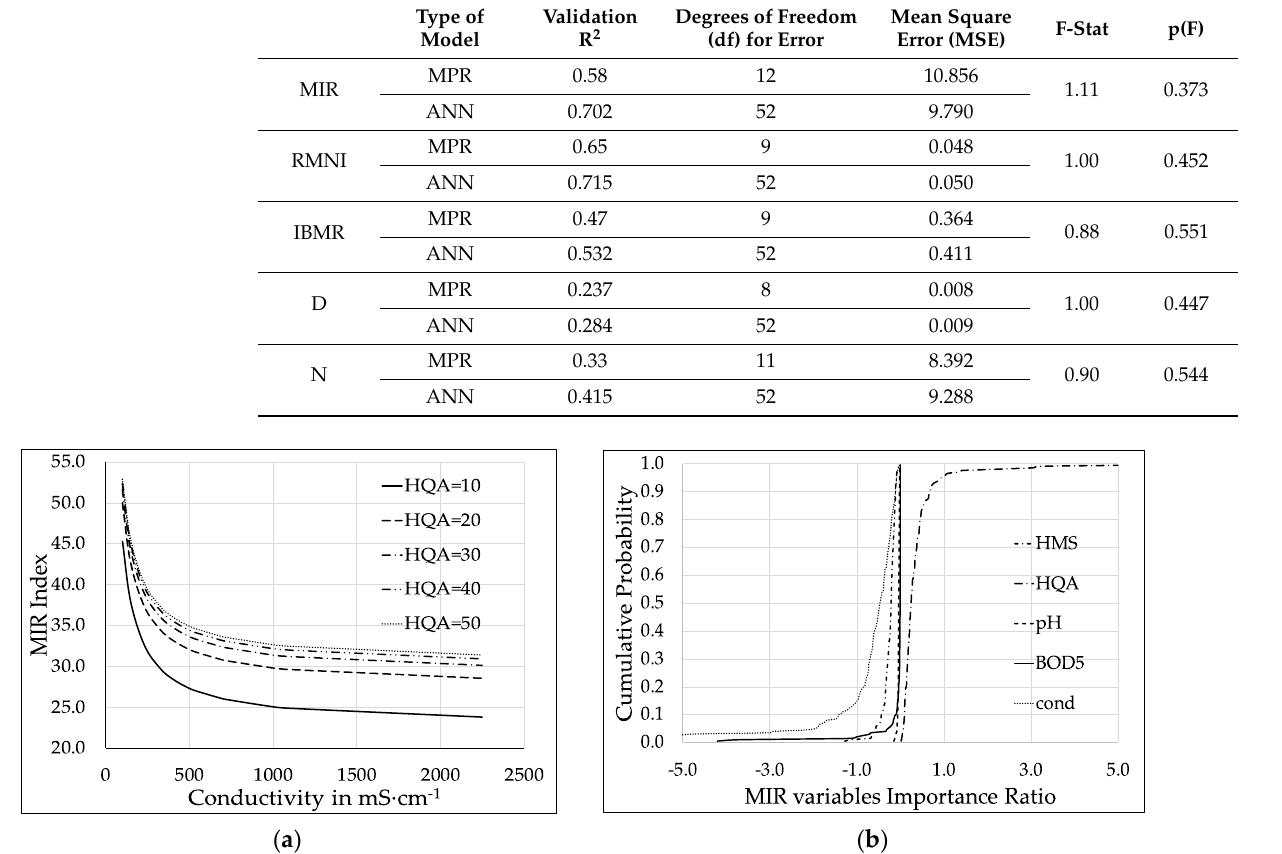
Degrees of Freedom Mean Square Error (df) for Error (MSE)